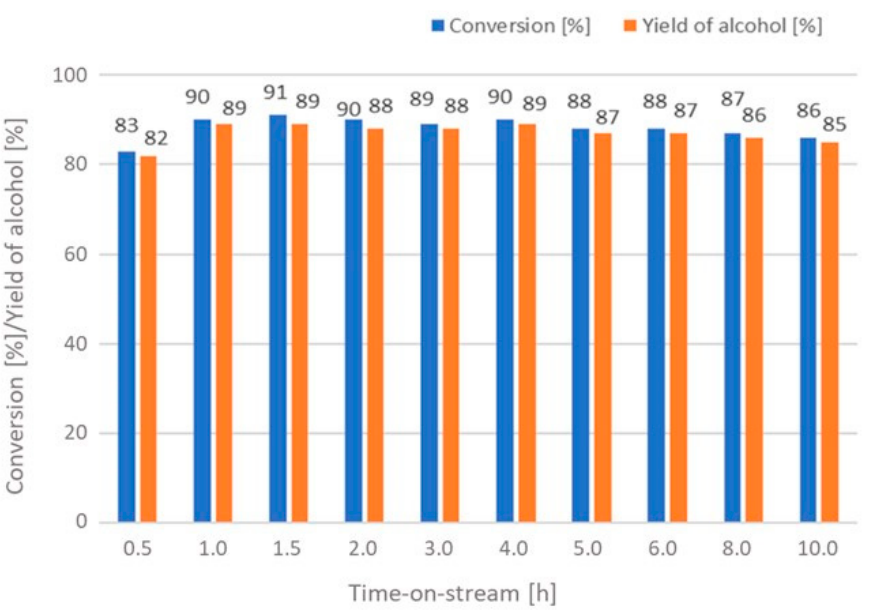
Figure 6. Vapor phase transfer hydrogenation of benzophenone with 2-propanol in the presence of MgO catalyst. Time-on-stream test. Reaction conditions: T = 573 K, D/A = 8, LHSV = 3 h − 1 , V N2 = 3 dm 3 h − 1 .